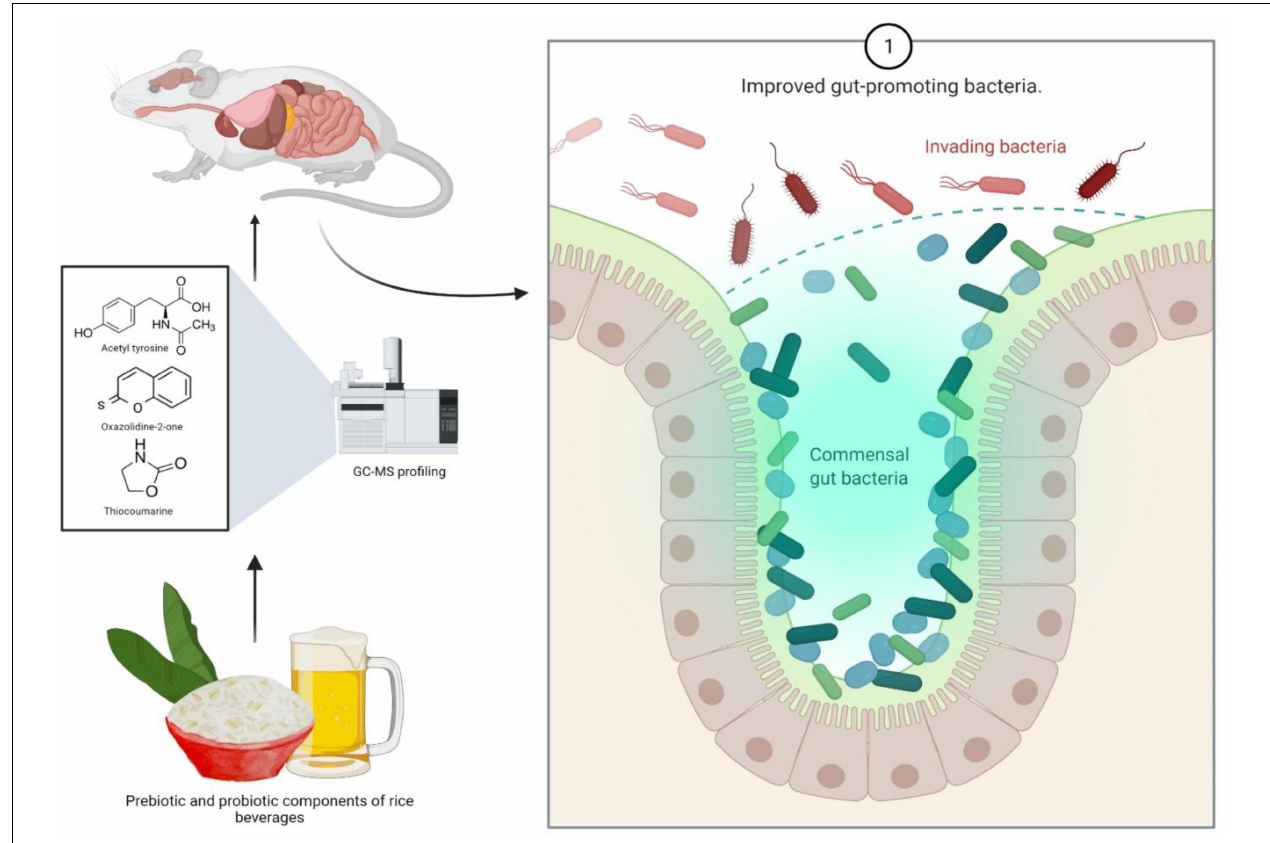
FIGURE 4 | Rice beer appears to contain bioactive molecules, indicating the presence of prebiotics, which have a number of health benefits, including the ability to fight infections and regulate gut